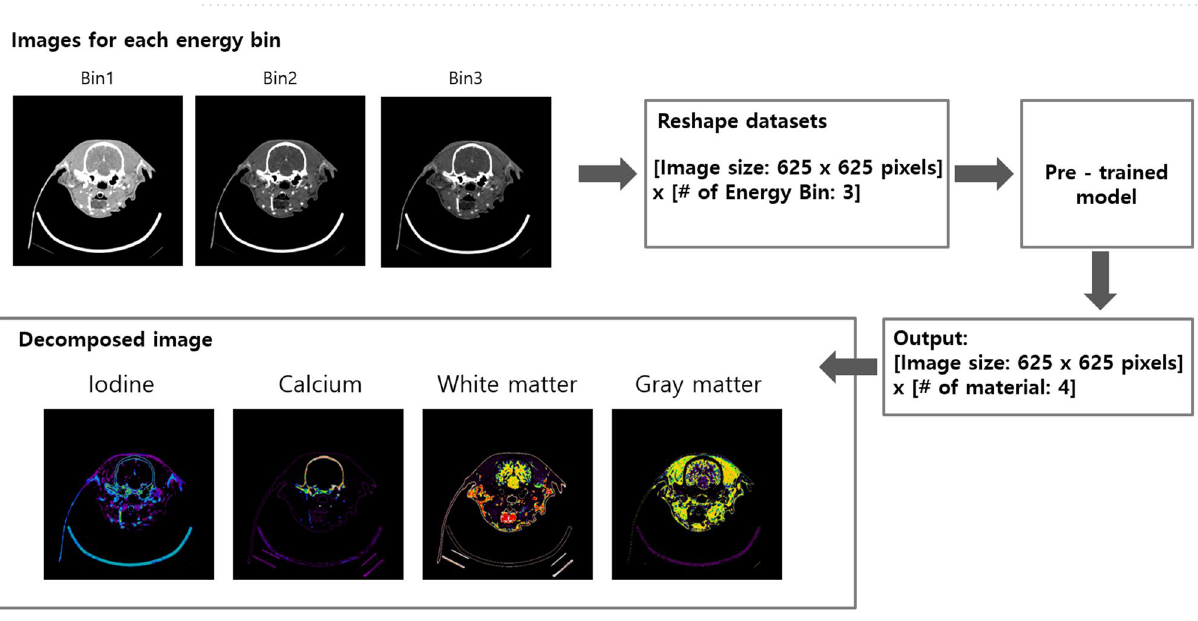
Figure 4. An example of application of the network for material